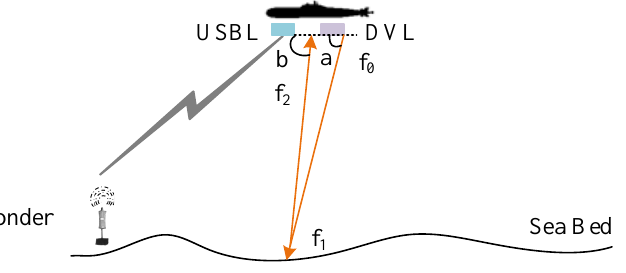
Figure 1. Sketch of AUV positioning.